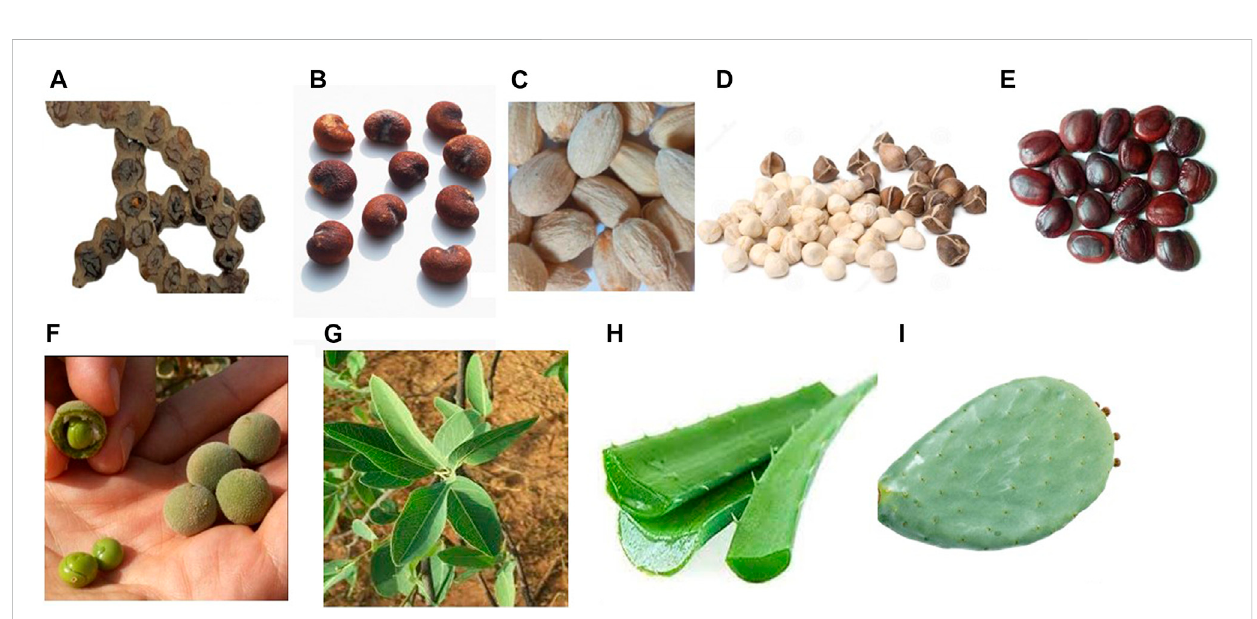
FIGURE 2 Accacia nilotica seeds (A) ; Adansonia digitata seeds (B) ; Balanites aegyptiaca seeds (C) ; Moringa Oleifera seeds (D) ; Tamarindus indica seeds (E) ; Boscia senegalensis seeds (F) , Capparis corymbosa leaves (G) , Aloe vera (H) , Opuntia fi cus indica (I)